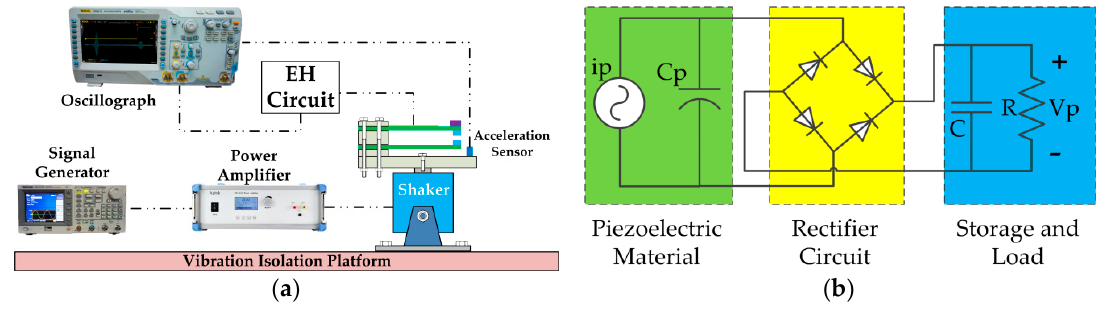
Figure 4. Experimental platform setup diagrams: ( a ) Components connection; ( b ) Energy Harvesting Circuit.